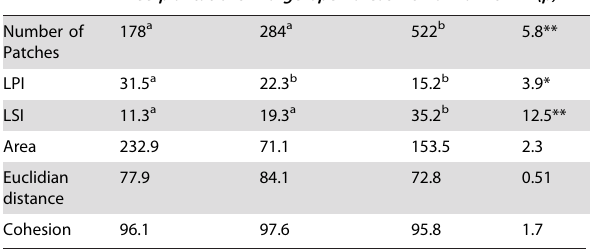
Table 4. Relation between dominant anthropogenic land use and spatial